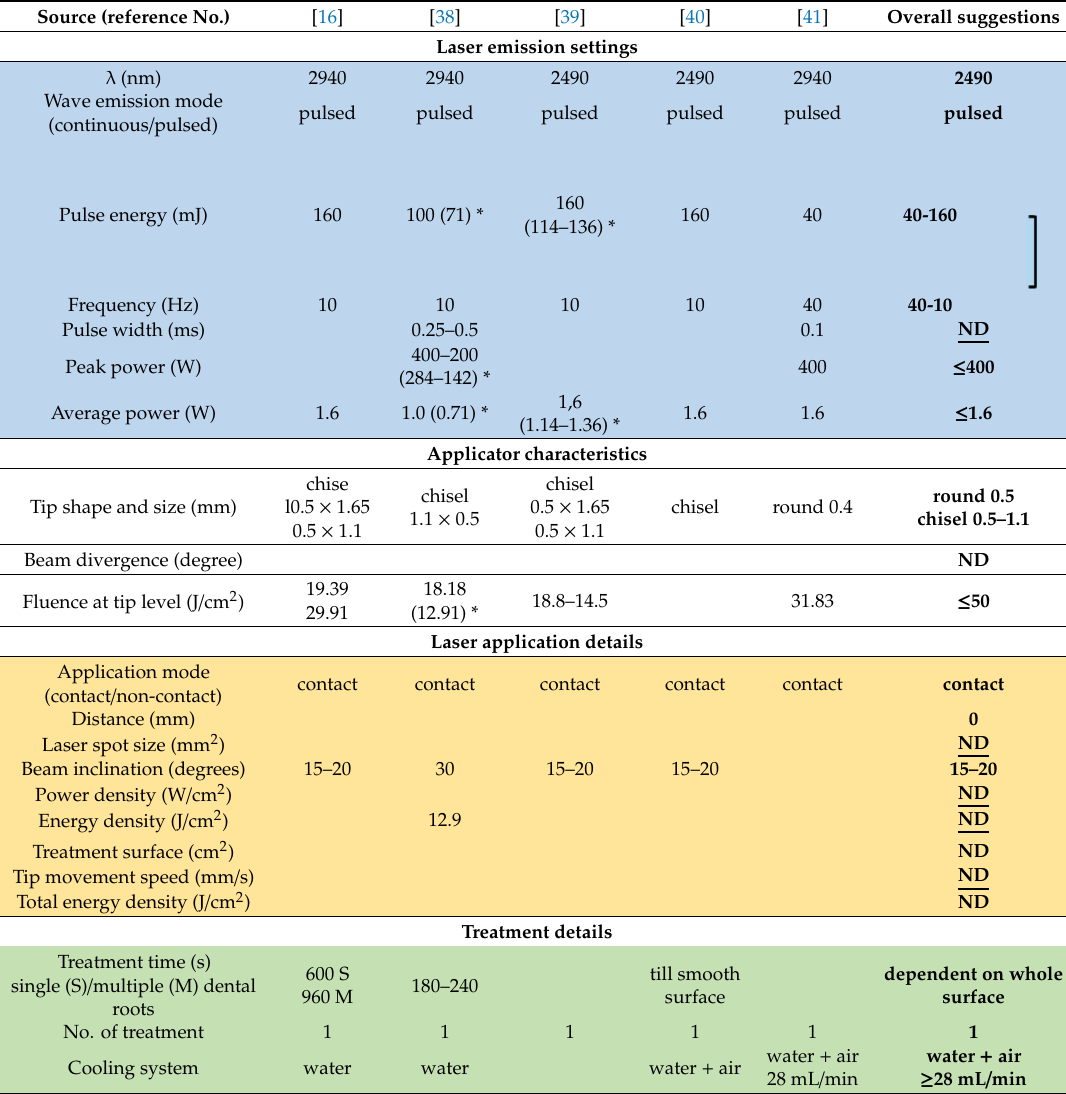
Table 1. Suggested parameters for photoablative Er:YAG laser. Table 2. Suggested parameters for photoablative Nd:YAG